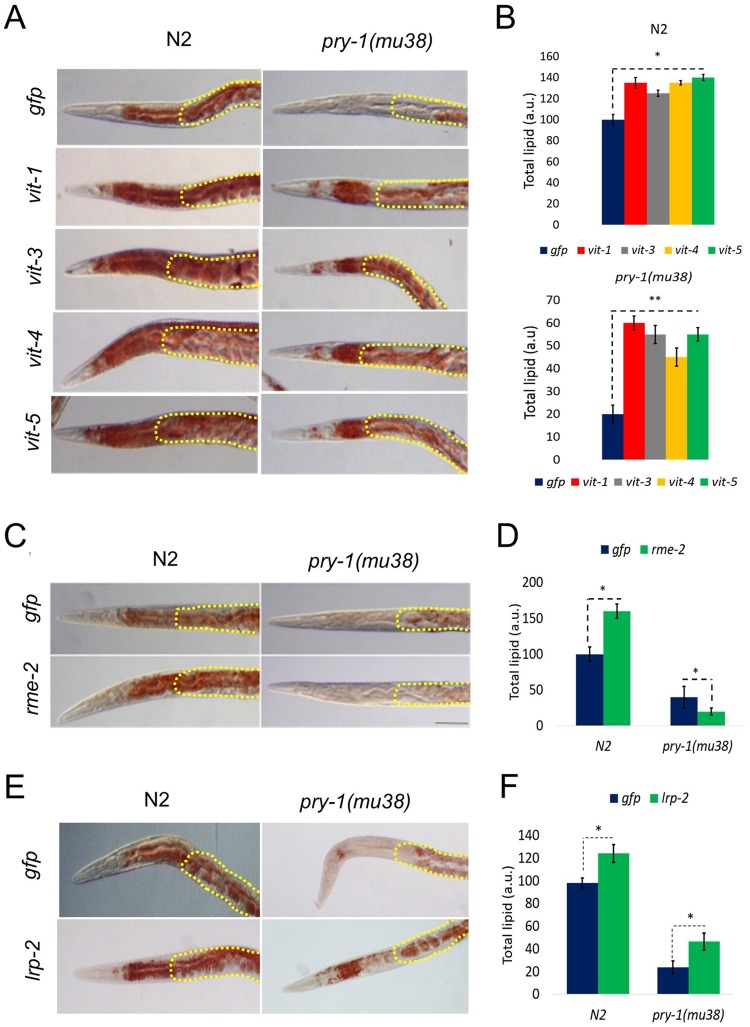
Vitellogenin mediated lipid metabolism in pry-1 mutants.(A) DIC micrographs of representative N2 and pry-1(mu38) adults stained with Oil Red O following vit RNAi. Areas marked with dotted lines show germline and eggs. (B) The corresponding Oil Red O quantifications following each treatment. (C) Representative images of N2 and pry-1(mu38) following rme-2 RNAi knockdown. (D) The histogram shows Oil Red O intensity in N2 and pry-1(mu38). (E) Representative images of N2 and pry-1(mu38) following lrp-2 RNAi knockdown. (F) The histogram shows Oil Red O intensity in N2 and pry-1(mu38). Data represents the mean of at least two replicates and error bar represents the SEM. At least 50 animals were quantified in each batch. *p < 0.01, **p < 0.001.